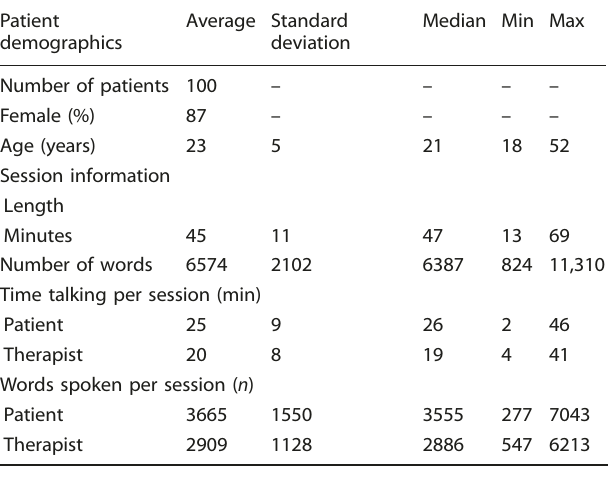
Table 2. Similarity between the human-transcribed reference standard and ASR-transcribed sentences. Word overlap Semantic